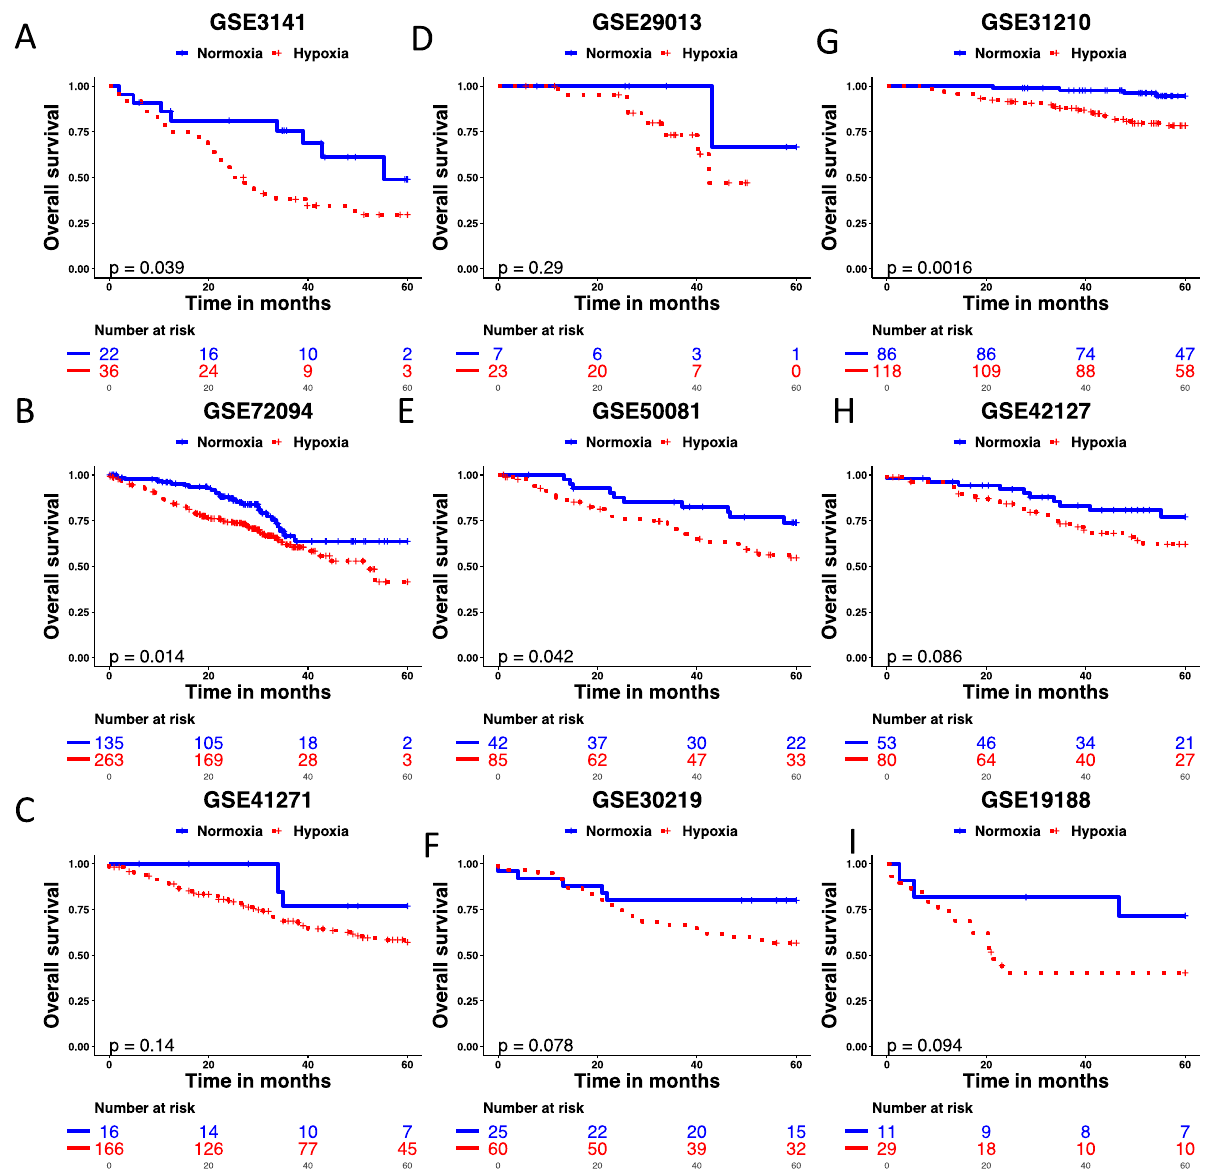
Figure 3. Perfomance of the 28-gene signature in nine independent cohorts. Kaplan–Meier curves for overall survival shown for nine LUAD validation datasets with tumours classified as hypoxic or normoxia based on centroids. LUAD lung